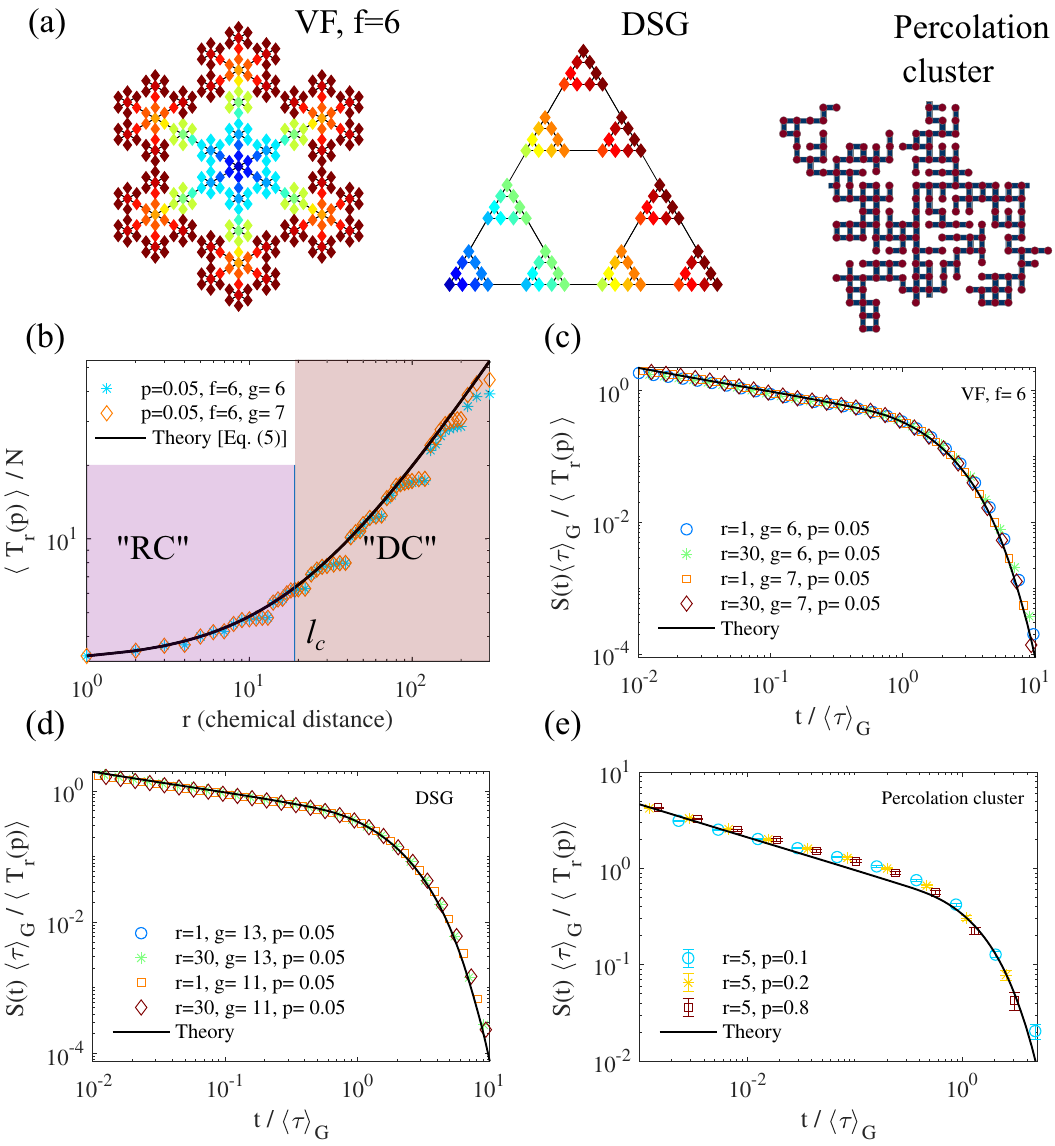
Fig. 2 Distributions of reaction times for compact transport. ( a ) Fractal networks for which we performed simulations: Vicsek fractal (VF), here of functionality f = 6, dual Sierpinski gasket (DSG), and two-dimensional percolation cluster (a 2D network in which half the bonds are randomly suppressed). For the VF and DSG, the color codes the distance to the reactive site, taken at an apex for DSG and at the center for VFs. ( b ) Mean Reaction time for VF and an absorption probability p = 0.05. Reaction Controlled (RC) and Diffusion-controlled (DC) regimes appear respectively below and above the length l c de fi ned in Eq. (6). ( c ) – ( e ) Survival probabilities, in rescaled coordinates for various generations g and initial distances r for ( c ): VF, f = 6, ( d ): DSG and ( e